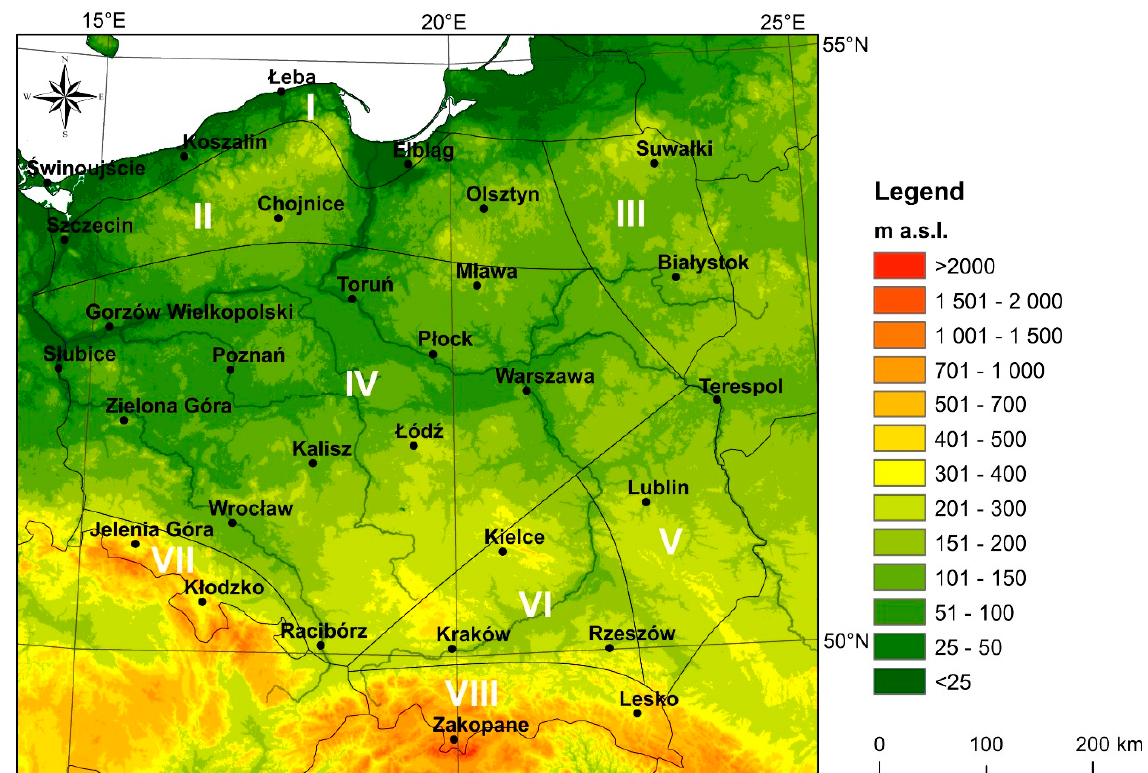
Figure 1. Location of meteorological stations and their locations in bioclimatic regions of Poland (I—Coastal, II—Lakeland, III—North-East, IV—Central, V—South-East, VI—Upland, VII—Sudetic, VIII—Carpathians; according to B ł a ż ejczyk [37]).